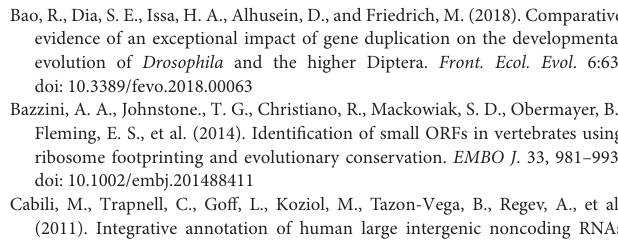
FIGURE 1 | phenotypes to natural selection under environmental pressure. (B) Scheme for coding potential maturation, a hypothetical mechanism that increase the translation efficiency of a mRNA after a smORF has been selected for (selected effect) in a transcript with suboptimal coding features. On the left, coding potential immaturity; in the middle, coding potential maturation; on the right, coding potential maturity. During the coding potential immaturity phase, newly selected smORFs are observed in transcripts with suboptimal coding features, either in long non-coding RNAs or as alternative smORFs in canonical mRNAs. Although canonical mRNAs exhibit optimal coding features, alternative smORFs are usually secondarily or pervasively translated; thus, some alternative smORFs may reside in suboptimal coding regions. During the coding potential maturation phase, natural selection and genetic drift may act in different parts of a transcript. While natural selection acts by fixing the selected parts, genetic drift acts by changing the non-coding parts of a transcript, as postulated by the nearly neutral theory (Ohta, 2002). Natural selection promotes fine-tuned adjustments to the selected phenotypes, such as synonymous mutations and CDS modifications. Genetic drift can establish adaptive mutations in a transcript by evolving sequences that potentially increase smORF translation, such as the Kozak consensus, regulatory upstream ORFs, internal ribosome entry sites (IRES) and increases in GC content. Additionally, other adaptive modifications not directly related to sequence mutations in transcripts might increase smORF expression, such as the 5 ′ cap, 3 ′ poly(A) tail, cis-regulatory elements in the genome and, in the case of alternative smORFs, independent gene unit generation by retrotransposition. Importantly, the acquisition of optimal coding features might be favored after the smORF has been selected for, because modifications driven by genetic drift could be fixed by natural selection if they improve the translation efficiency of the newly selected smORF. Before the smORF has been selected for, eventual optimal coding features acquired could rapidly disappear during genetic drift evolution without fixation. Alternatively, mutations evolved by genetic drift can silence the gene. Finally, smORFs reach the coding potential maturity phase when optimal coding features are acquired and translation efficiency increases. Consequently, the translation rate of smORF peptides is largely increased upon completion of the described process, contributing to the establishment of molecular innovations and protein coding gene